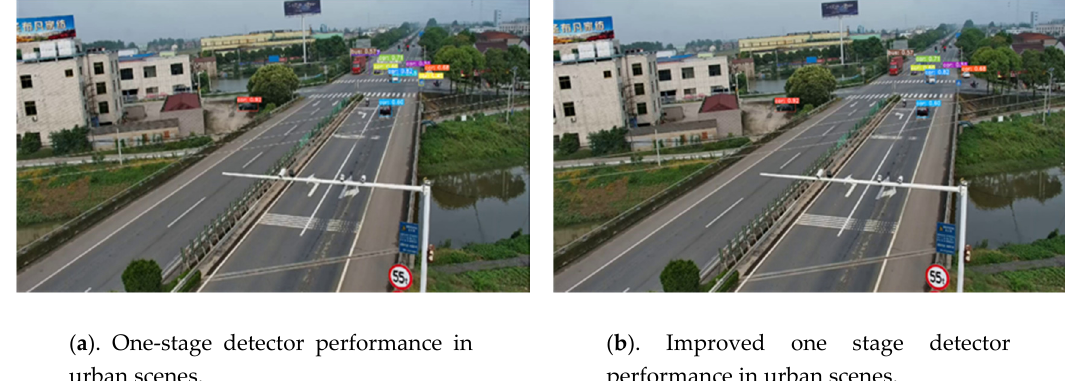
Figure 6. Comparison of improved one-stage detector and one-stage detector in urban environment.